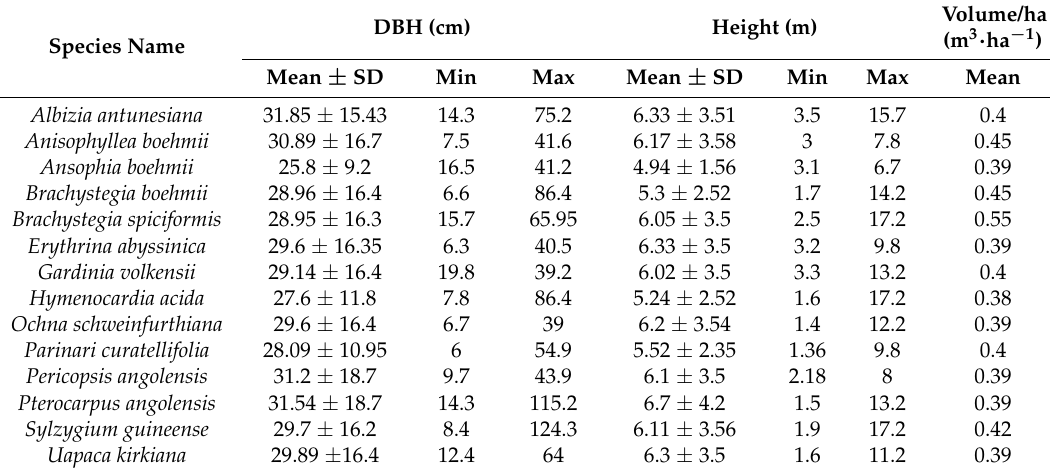
Table 3. Characteristics of trees species in the study